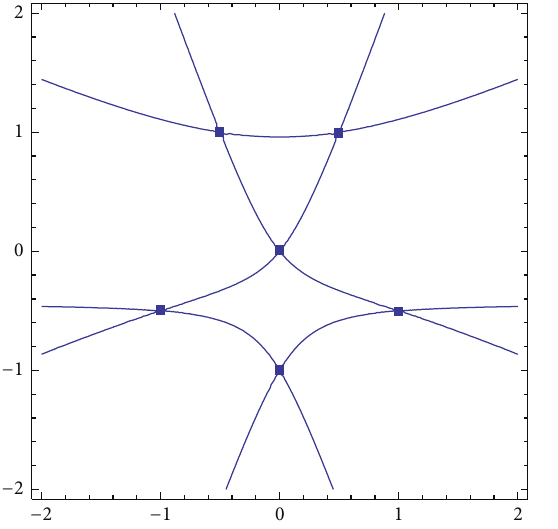
Figure 6: Real part of 𝑓(𝑥,𝑦) = 0 in Example